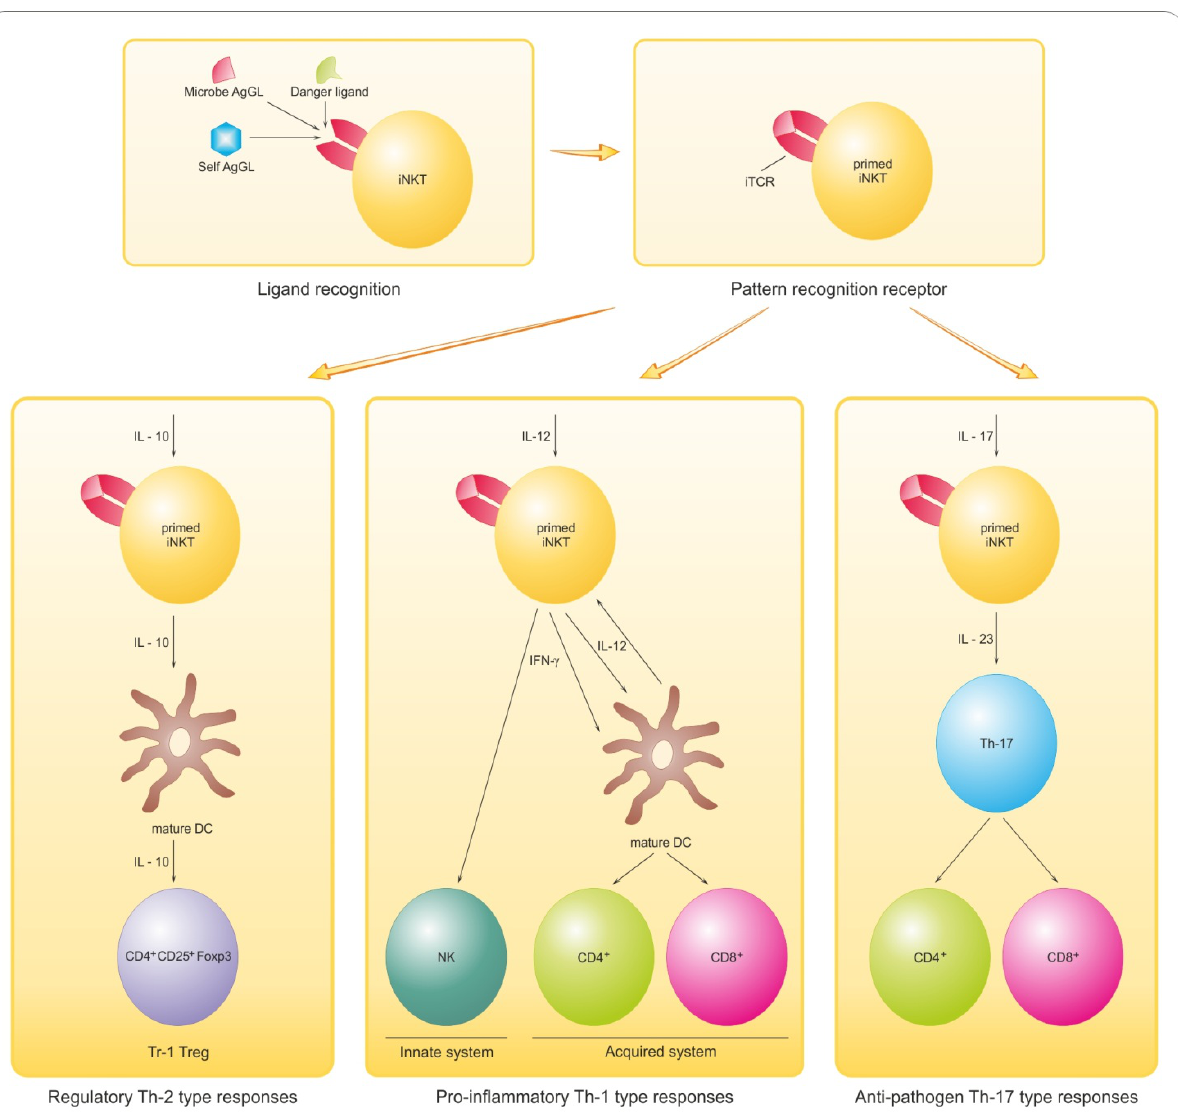
Figure 5. INKT cell-mediated immune responses (IR). Different antigenic GLs: microbial GLs; danger ligands; self antigens (Ags) compete for binding to iTCR; a pattern recognition receptor (PRR). Recognition is for different lipids—e.g., GLs, PLs and IR can be to microbial GLs (usually with high affinity) and overlap IR to self Ags (weaker affinity). The iNKT is (1) primed by the GL/iTCR/CD1d receptor complex and (2) responds according to environment, mainly cytokines-dependent with diverse outcomes: (i) pro-inflammatory (Th-1 type responses), (ii) regulatory (Th-2 type) or (iii) anti-pathogen (Th-17 type) as shown for IL-12 for iNKT pro-inflammatory functions; for an IL-10-driven response generating regulatory Tr1 Treg (e.g., CD4 + CD25 + Foxp3) and also anti-pathogen activity triggered by IL-17 and IL-23. From Hogan et al. [210] with permission of OMICS Publishing